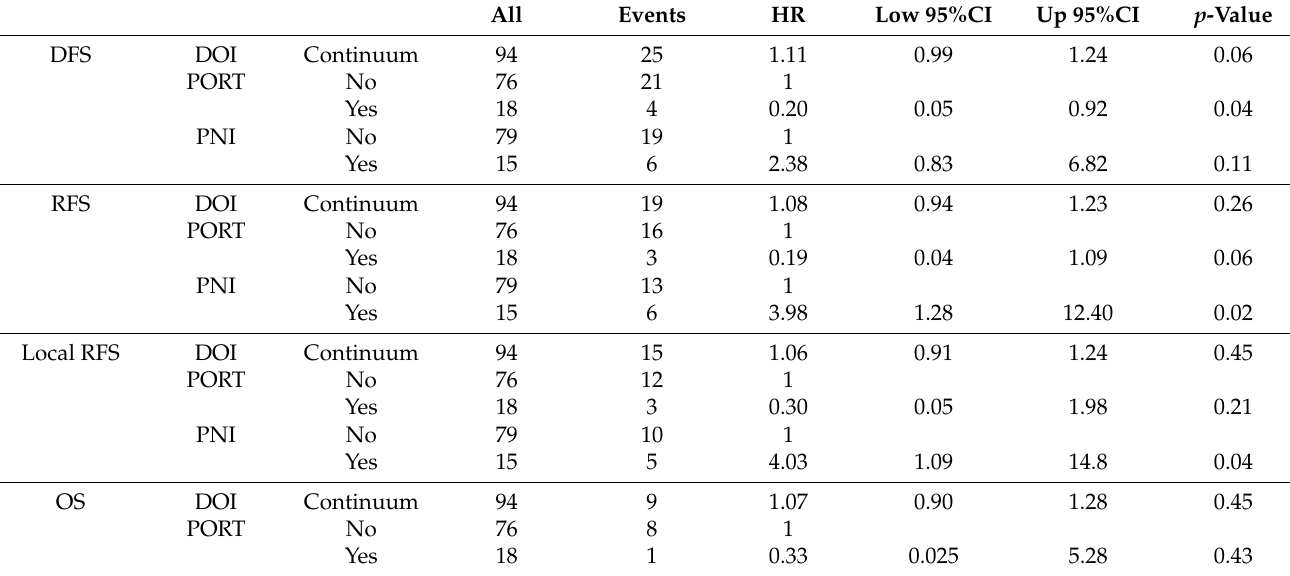
Figure 2. Disease free survival and local relapse free survival according to DOI ( a , b ) and PNI ( c , d ). PNI = perineural invasion, DOI = depth of infiltration. PNI = perineural invasion, DOI = depth of infiltration. Table 4. Multivariable Cox proportional hazard